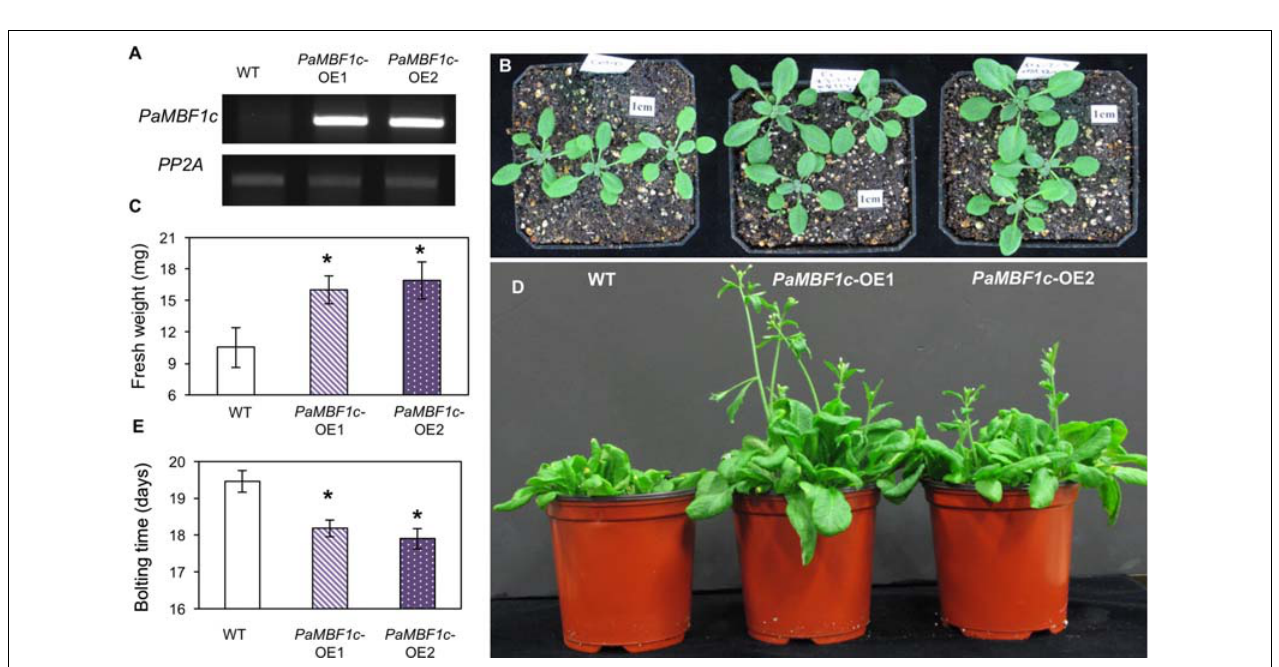
FIGURE 3 | Growth and development of PaMBF1c- OE lines. (A) Higher accumulation of transgene transcripts in PaMBF1c -OE lines were confirmed by semi-quantitative RT-PCR. (B) The size of PaMBF1c -OE lines was bigger than WT. Pictures were taken 12 days after germination. (C) Measurement of fresh weights per seedling revealed a better growth of PaMBF1c -OE lines in comparison to WT. (D,E) PaMBF1c -OE lines bolted earlier than WT. Error bars represents standard deviation of means ( n = 20). Asterisks indicate statistical significance in LSD test ( p <